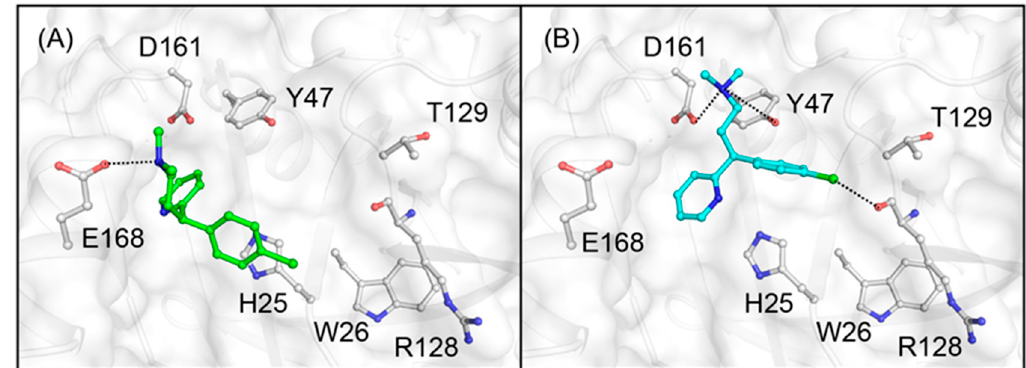
Figure 4. Simulated docking structures of cAGP with ( A ) ( R )-chlorpheniramine and ( B ) ( S )-chlorpheniramine. The docked compounds were represented as in Figure 3. Besides, the same colors were used for nitrogen and oxygen atoms, and the remarked amino acid residues as in Figure 3. Feasible interactions were depicted as dotted lines.